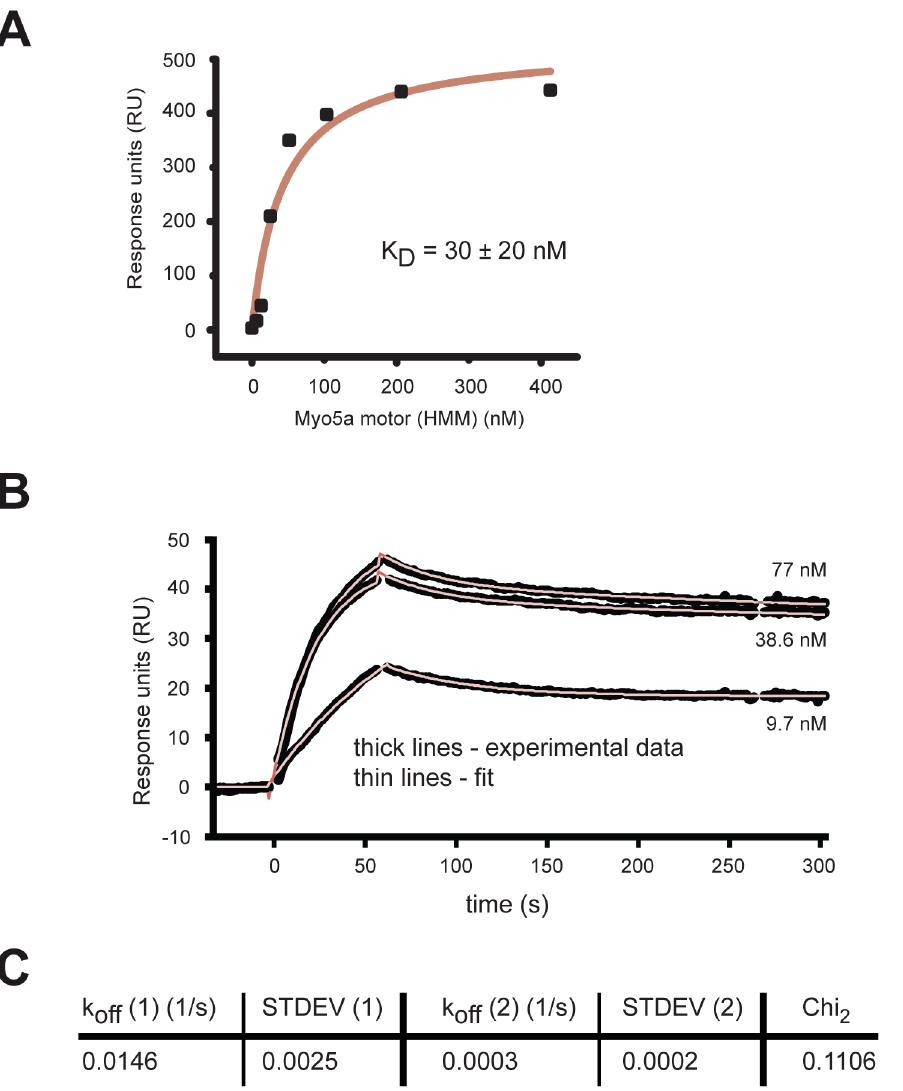
Myo5a. Figure S6 Electrostatic potentials of Myo5a, Myo5b, and Myo5c calculated with the program Swiss PDB